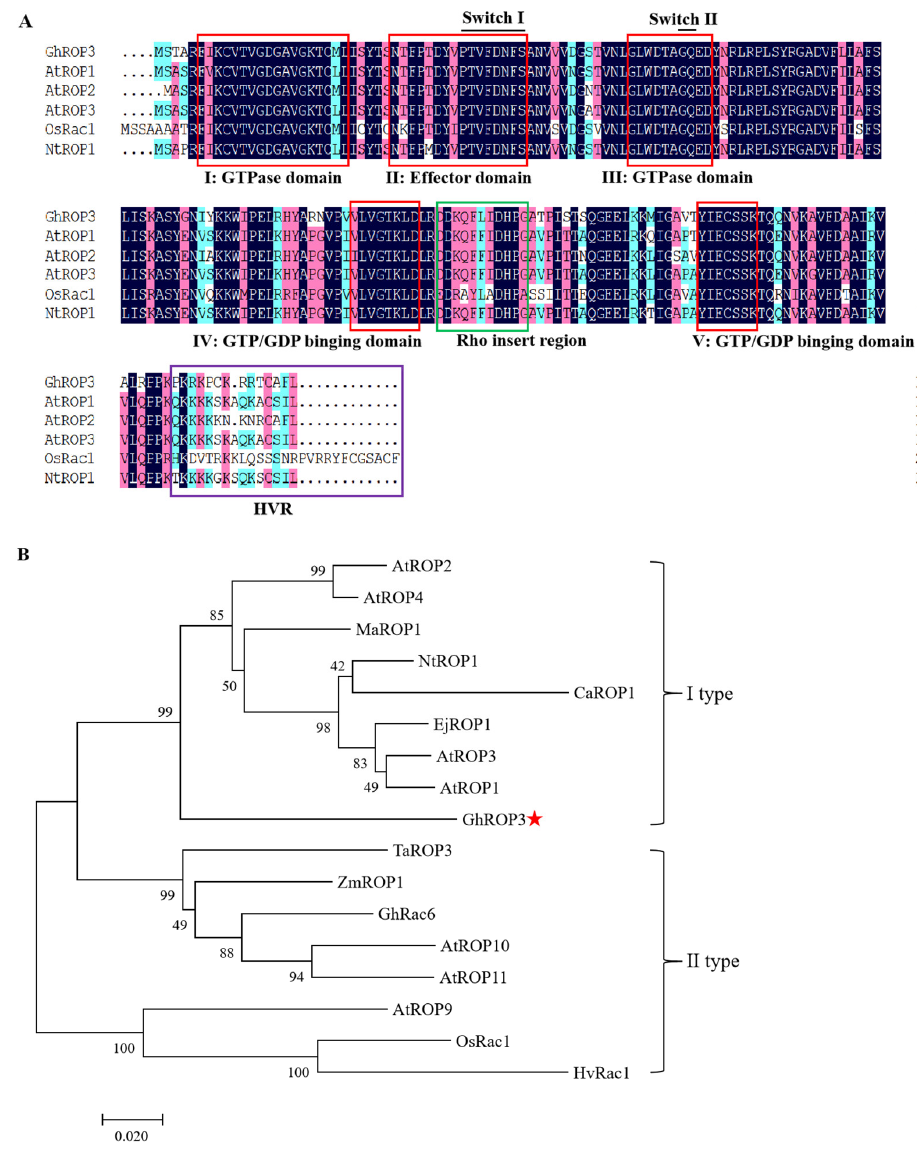
Figure 1. GhROP3 sequence analysis. ( A ) Multiple sequence alignment. ( B ) Phylogenetic tree analysis. Red star marks the target protein GhROP3.